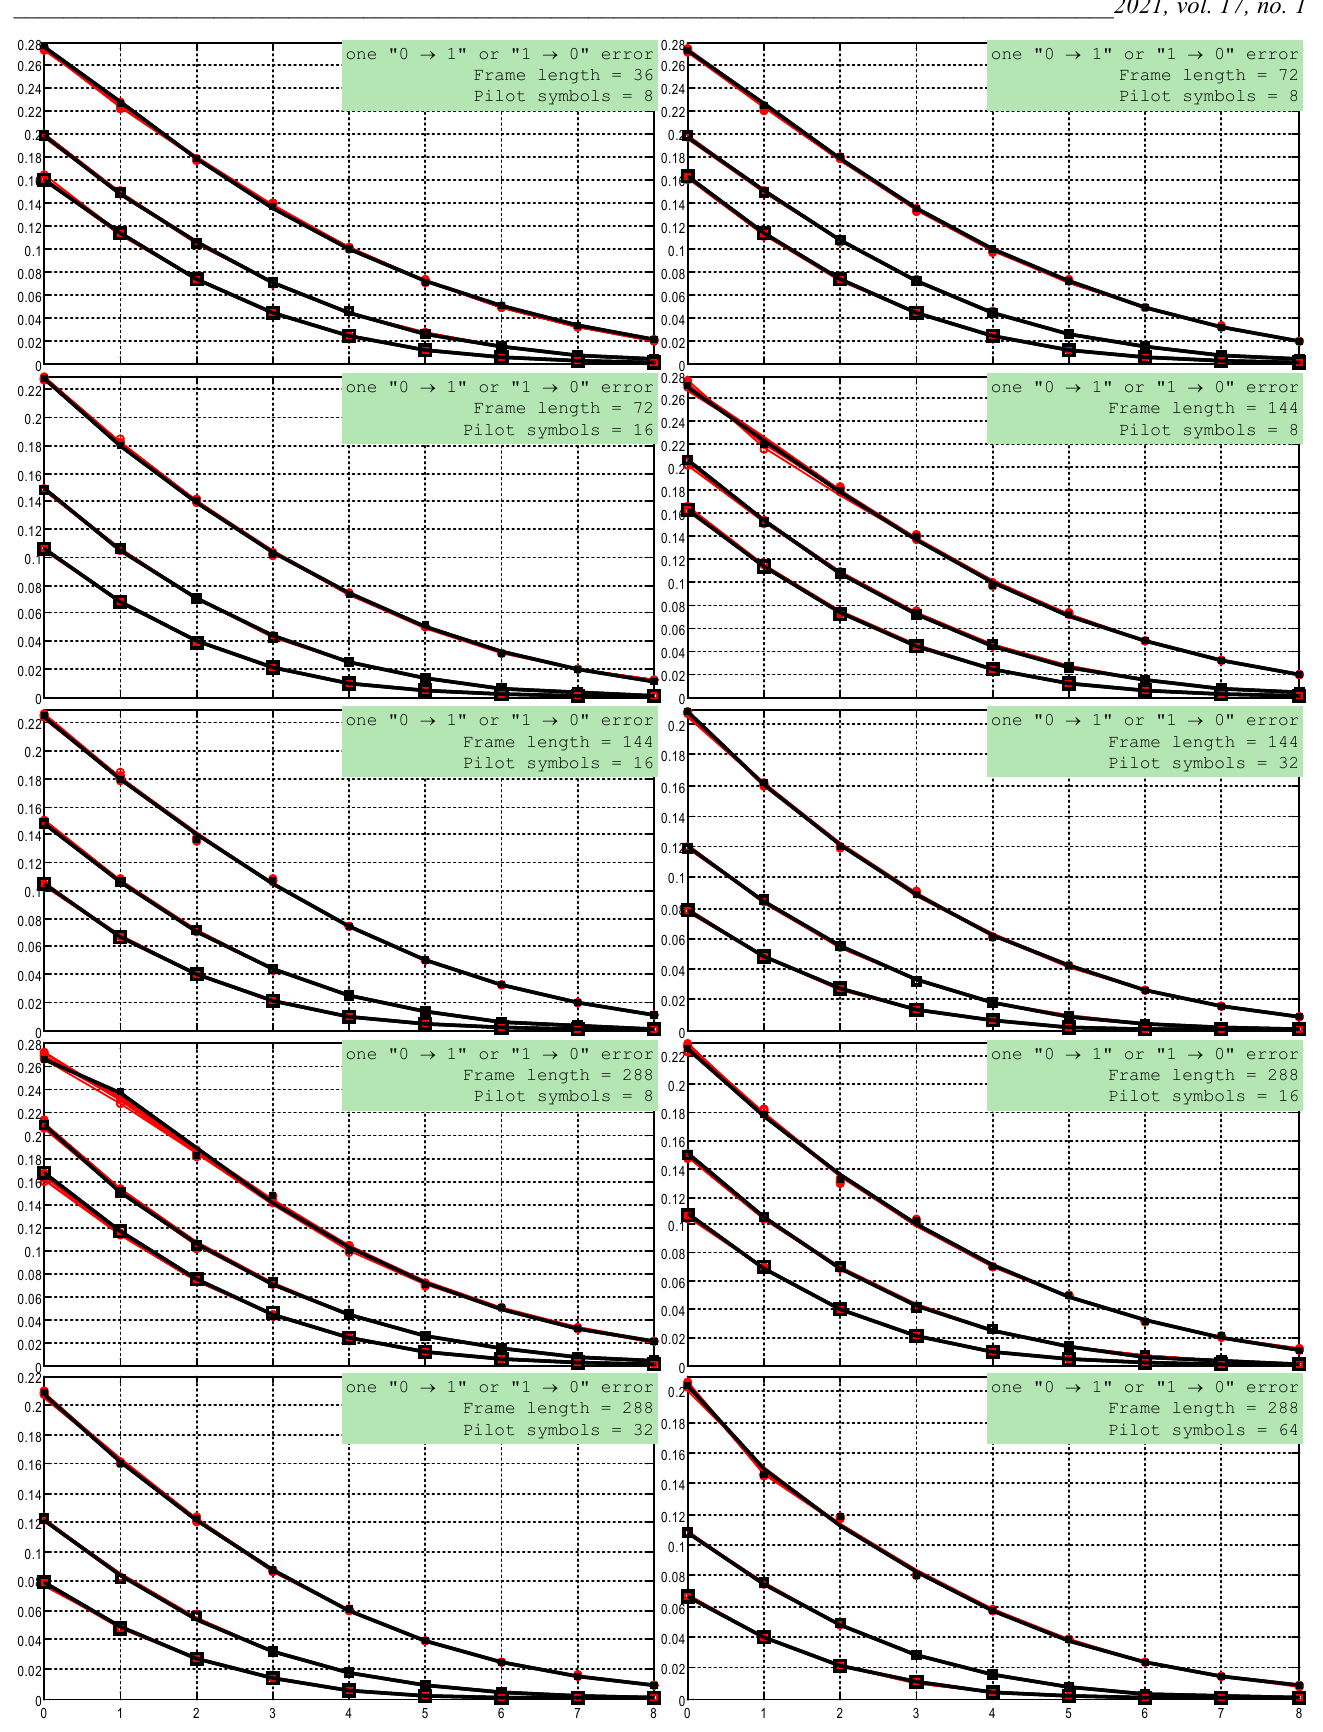
Fig. 4. The BER performance versus BENDR in the case of one indefinite pilot symbol error (“0→1” or “1→0”). This is PSdeO by simul ation case